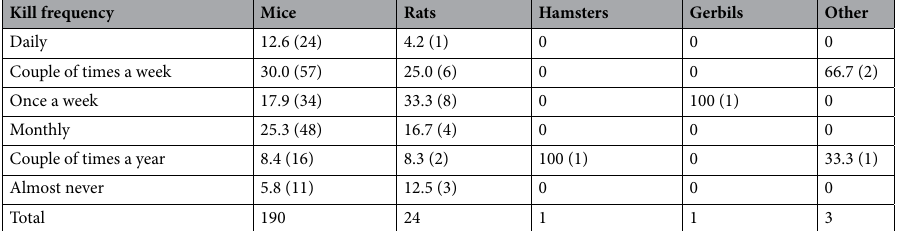
Table 2. Number of participants as a percentage (%) of respondents working with each species and the frequency of Schedule 1 killing use. Numbers in brackets represent the number of respondents reporting Schedule 1 killing frequency according to species.